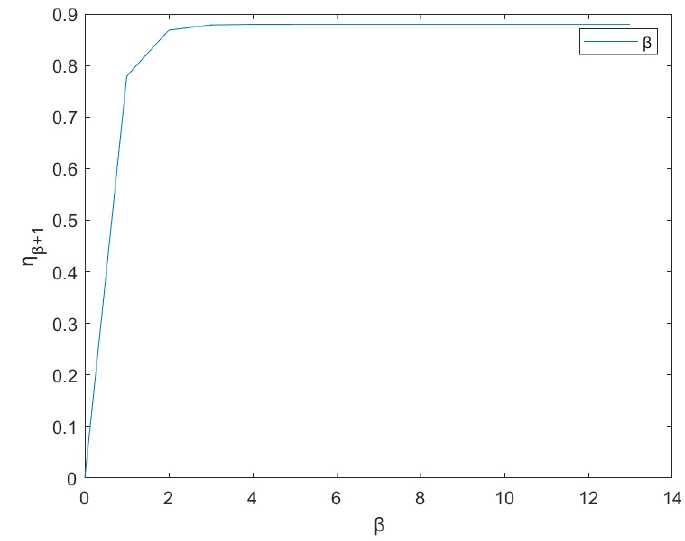
Figure 1. Convergence criterion